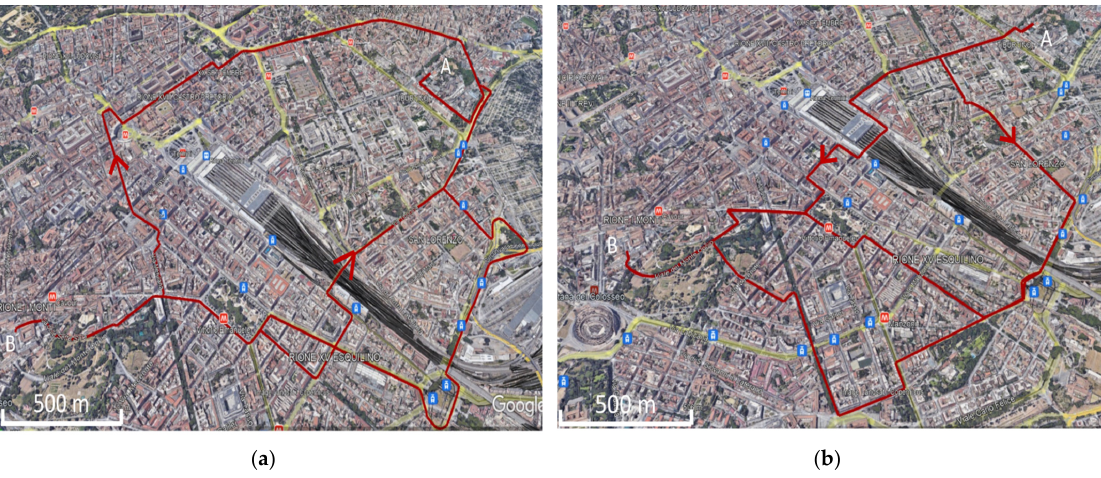
Figure 6. Google Earth maps of point-to-point routes: ( a ) Routes between points B and A (route 1, route 2 and route 3); ( b ) Routes between points A and B (route 4, route 5 and route 6).